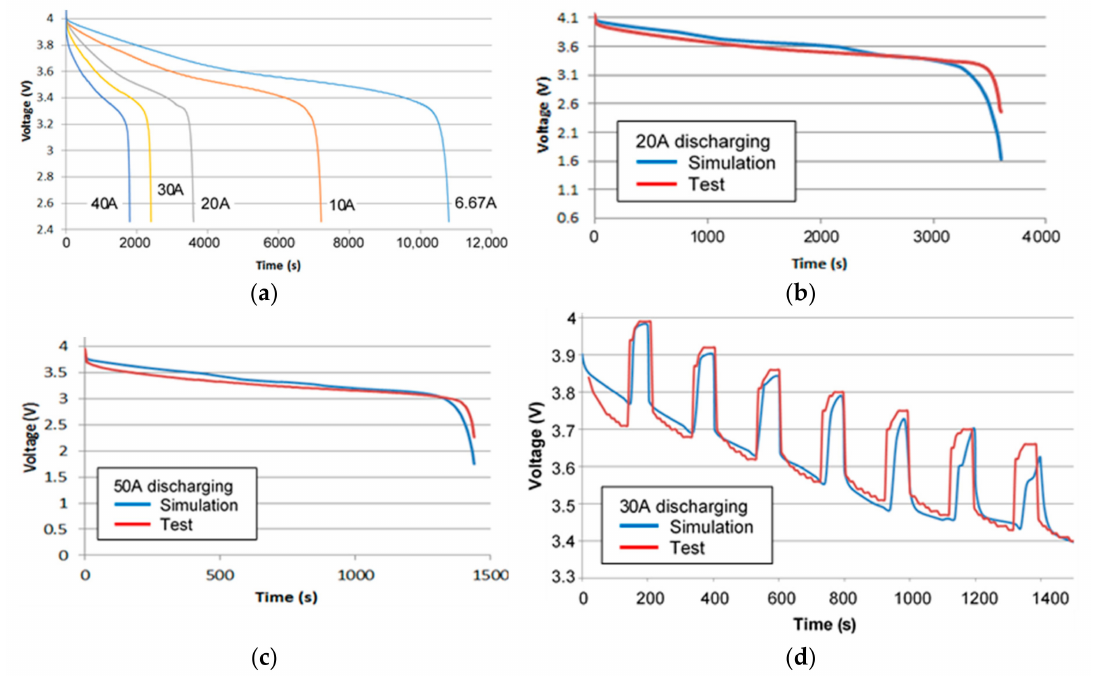
Figure 7. Examples of simulated and experimental discharging curves: ( a ) Averaged constant current discharging curves from tests; ( b ) simulated and test constant current discharging curves; ( c ) simulated and test constant current discharging curves; ( d ) simulated and test pulse